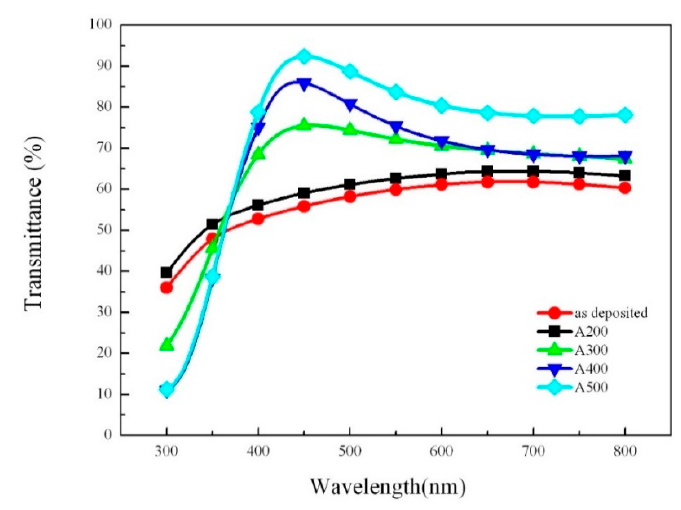
Figure 3. Optical transmittance of as-deposited and annealed Ti:SnO 2 films. Figure 3 . Optical transmittance of as-deposited and annealed Ti:SnO 2 films. Table 2. Effects of annealing temperature on energy gap ( Eg ) of Ti:SnO 2 films .